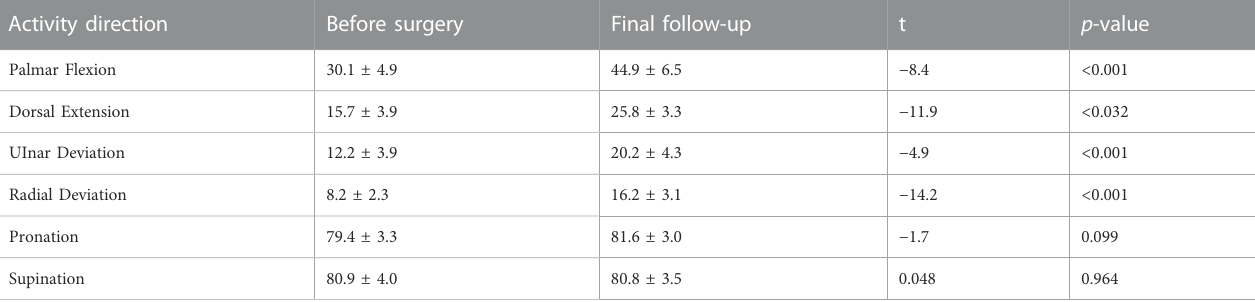
TABLE 3 Comparison of ROM before surgery and fi nal follow-up a . Activity direction Before surgery Final follow-up